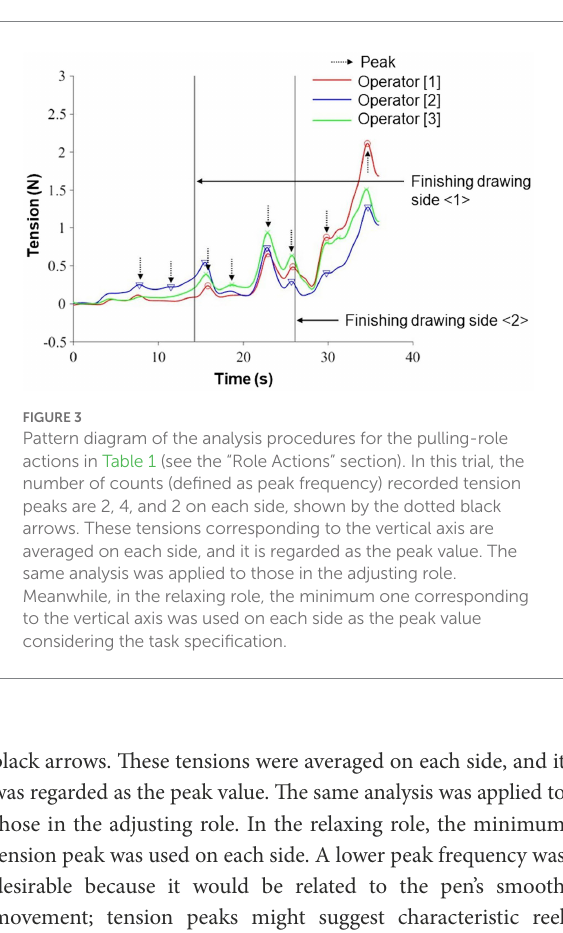
black arrows. These tensions were averaged on each side, and it